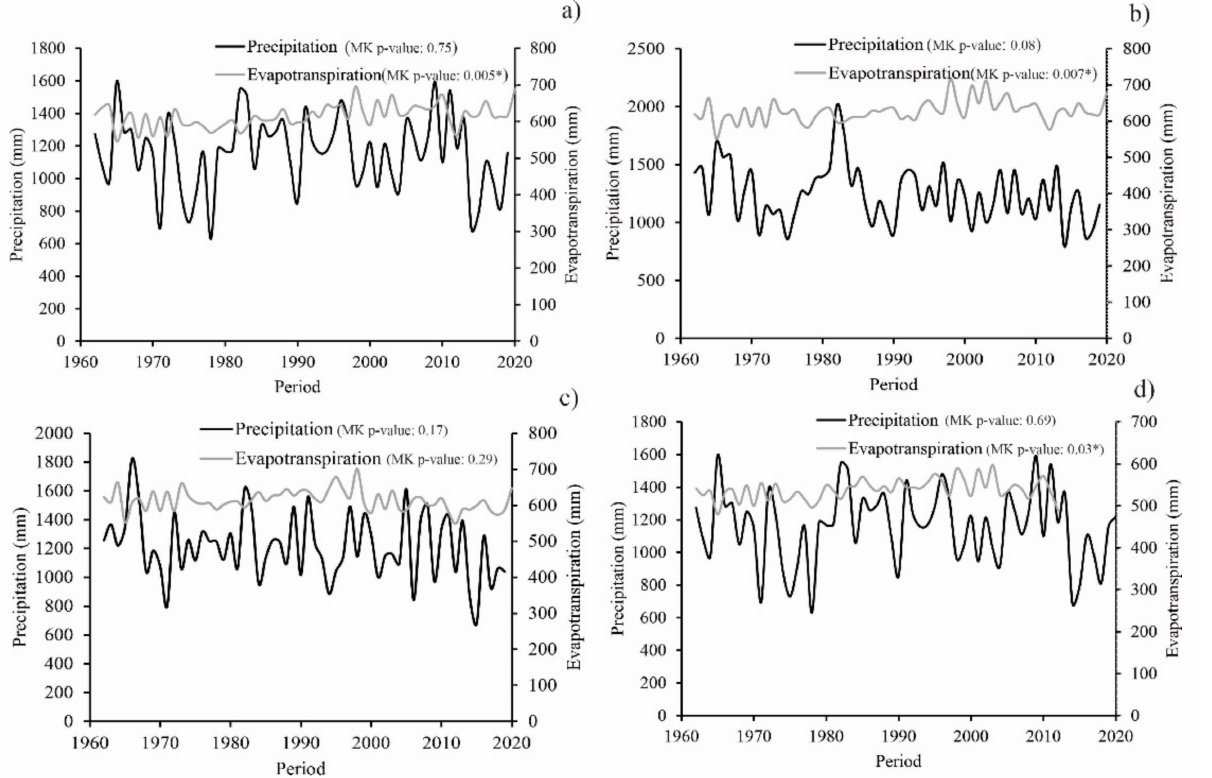
Figure 5. Temporal behavior of precipitation and evapotranspiration in the rainy period for the four weather stations in GRB-Furnas and respective Mann–Kendall test results. ( a ) Lavras (number 1-Figure 1); ( b ) Machado (number 2-Figure 1); ( c ) S ã o Lourenço (number 3-Figure 1); ( d ) Barbacena (number 4-Figure